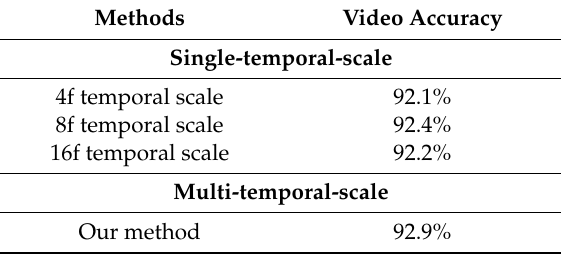
Table 5. Comparison of multi-temporal-scale method with single-temporal-scale methods on UCF101 split-1.